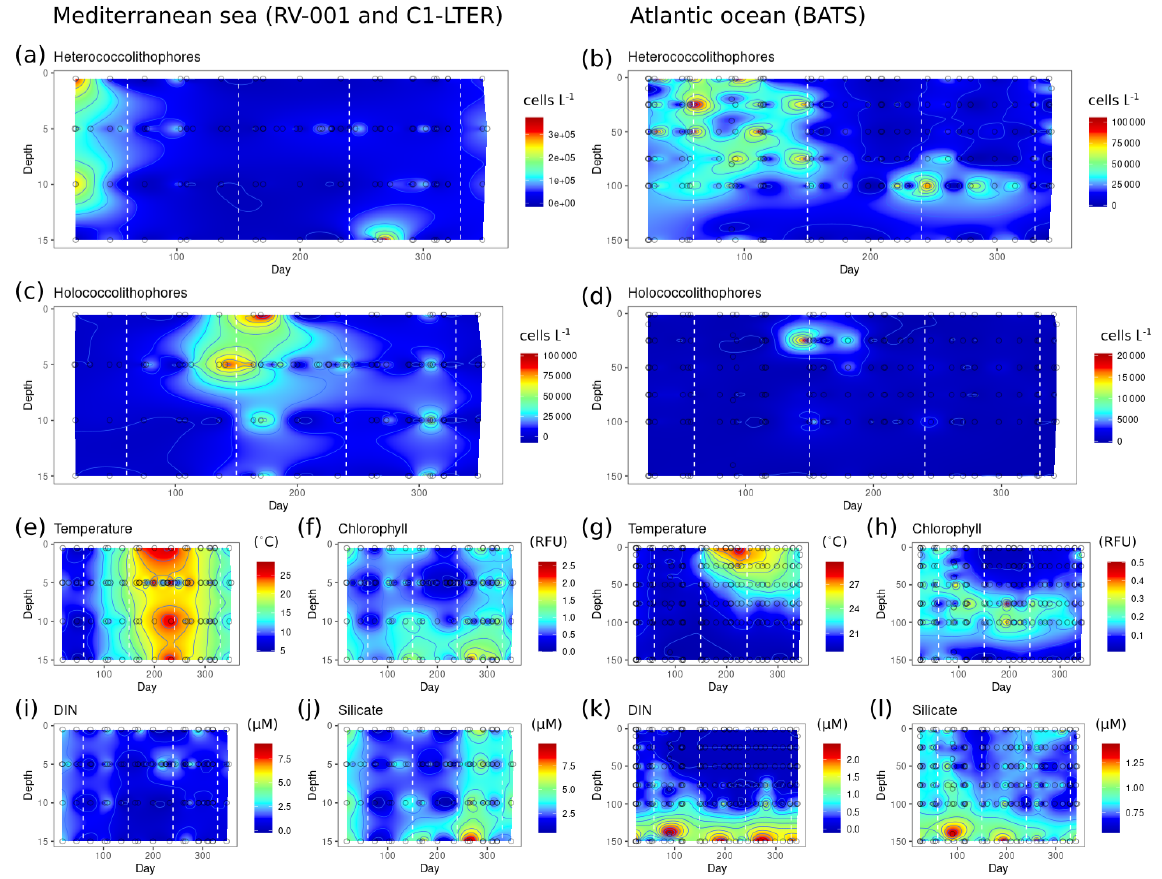
Figure 8. Seasonality of heterococcolithophores and holococcolithophores at the BATS station in Bermuda (left column) and the RV-001 and LTER-1 stations in the Mediterranean Sea (right column). Note that heterococcolithophores are most abundant in the winter, followed by a high abundance of holococcolithophores in the late spring and early summer: (a–b) heterococcolithophore abundance, (b–c) holococ- colithophore abundance, (e, g) temperature, (f, h) chlorophyll, (i, k) DIN (nitrite + nitrate), (j, l)